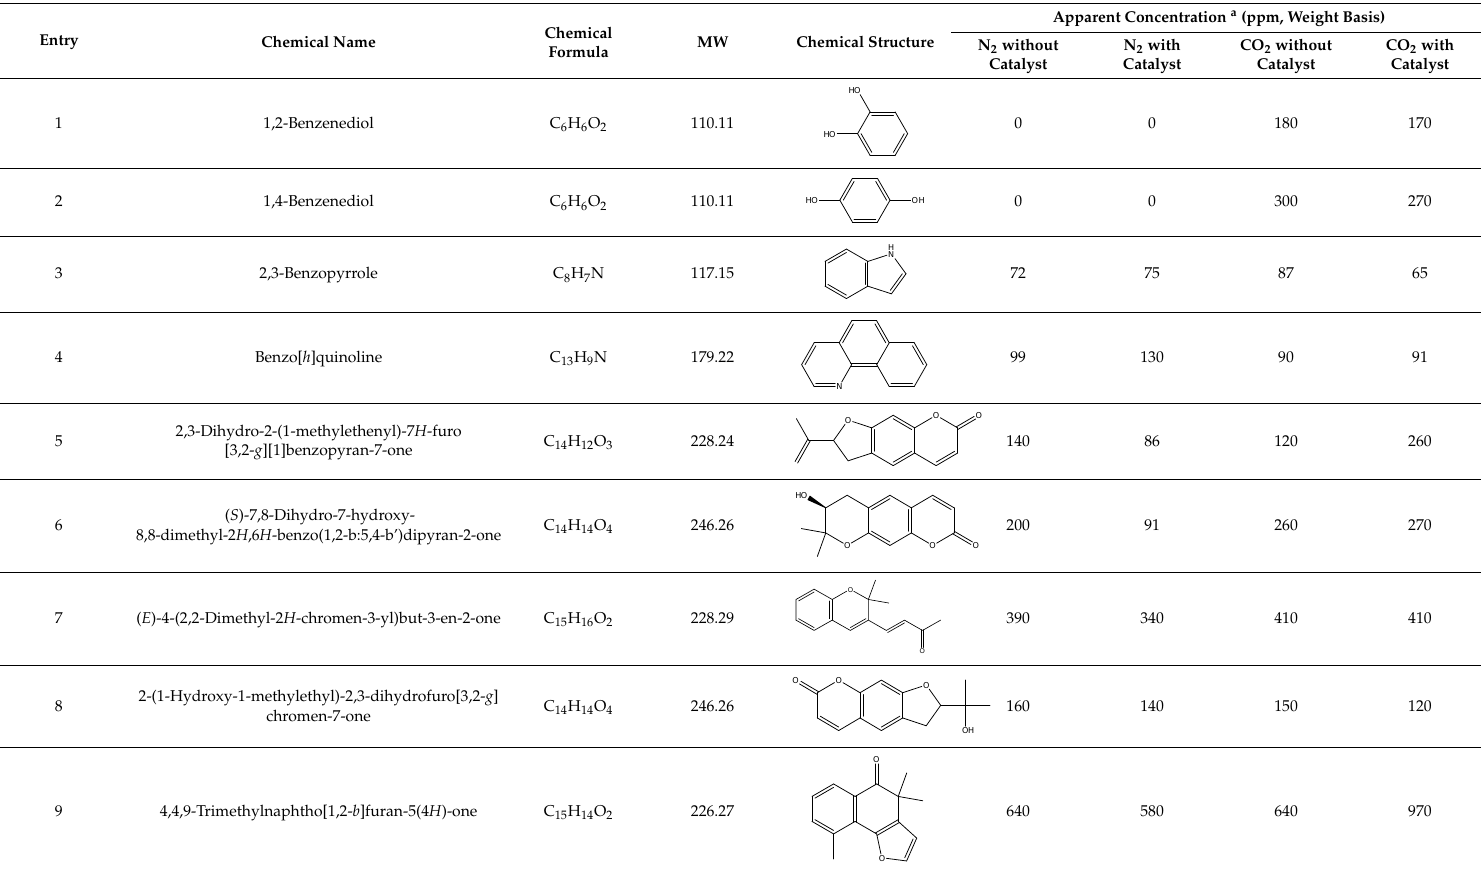
Table 3. Benzene derivatives identified in the pyrolytic products generated from the pyrolysis of the herbal medicine waste and their concentrations obtained from four different pyrolysis experiments. Mean values of replicates ( n = 3) are reported and standard deviations of the mean values are around 7%.